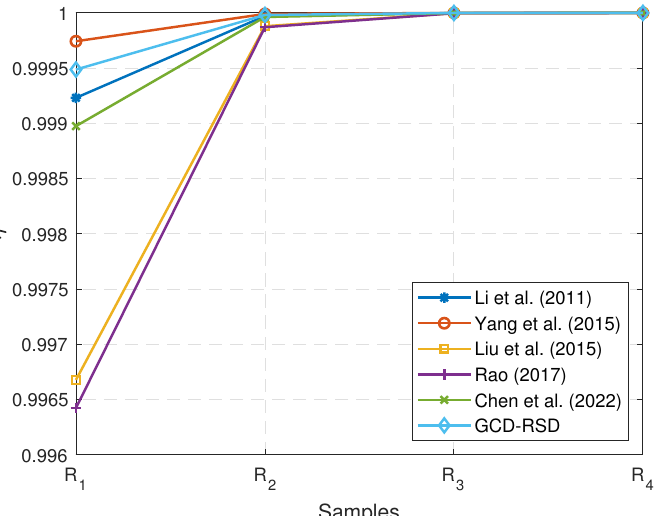
Figure 7. The comparison of efficient data rate η of the 6 schemes [15–17,19,28] and GCD-RSD in generating the ciphertext for the samples R 1 , R 2 , R 3 , and R 4